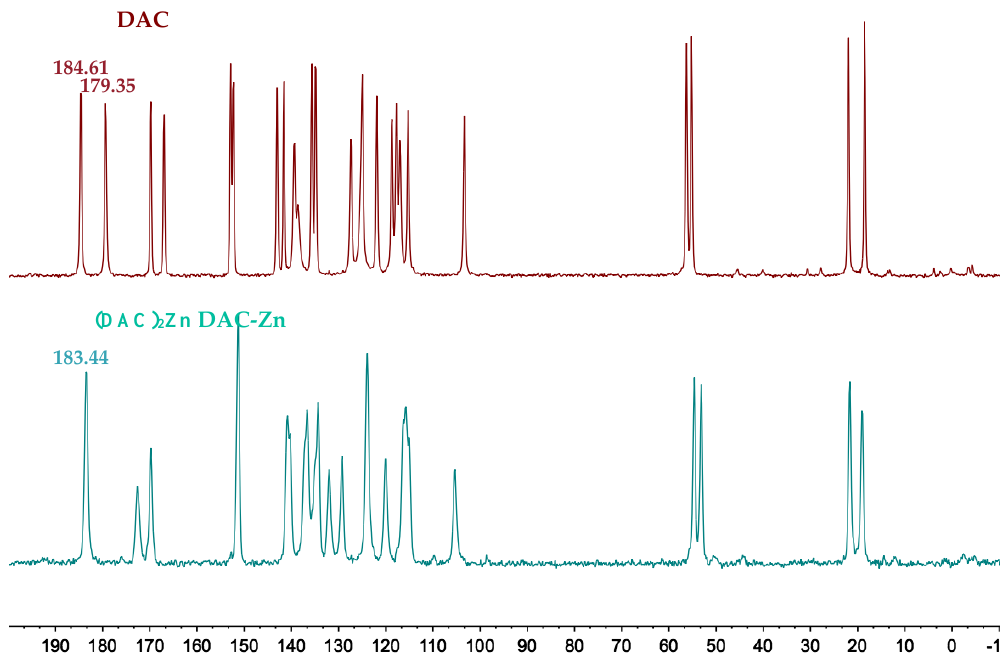
Figure 1. Comparison between 100 MHz 13 C nuclear magnetic resonance (NMR) spectra of DAC and (DAC) 2